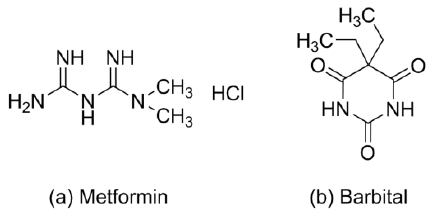
Figure 1. Chemical structures of ( a ) metformin and ( b ) barbital.